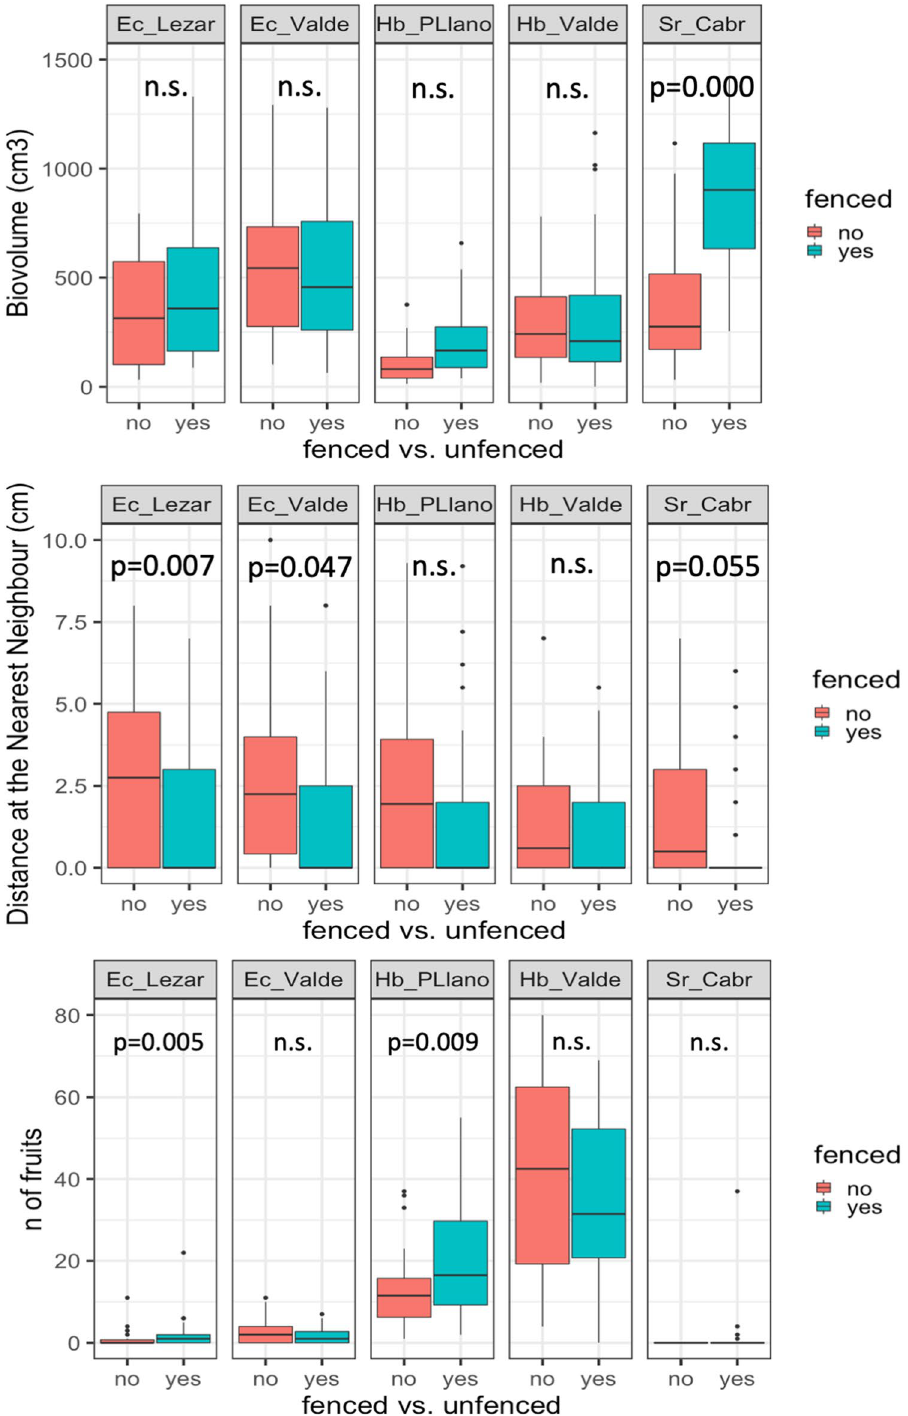
Figure 3. Boxplot of biovolume (top graphs), distance to the nearest neighbour (centre graphs), and number fruit production (bottom graphs) for fenced and unfenced individuals (n = 30 in all the cases) in all the studied populations (see Table S1). P values indicated for each pair comparison were obtained after permutational ANOVA. Abbreviations for species and populations: Ec_Lezar Erodium cazorlanum -Puerto de Lezar, Ec_Valde Erodium cazorlanum -Valdeazores, Hb_PLlano Hormathophylla baetica -Puerto Llano, Hb_Valde Hormathophylla baetica -Valdeazores, Sr_Cabr Solenanthus reverchonii -Cabrilla